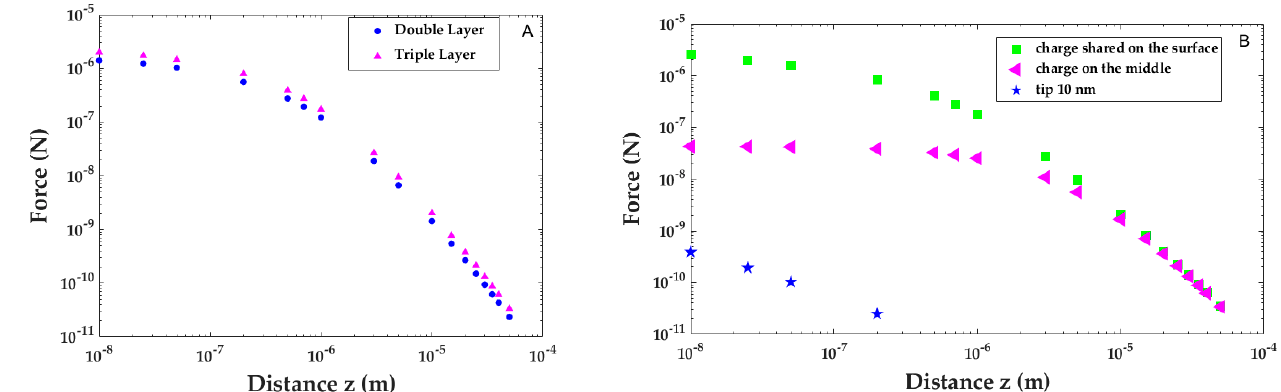
Figure 3. ( A ) Modeling of the interaction between a surface covered by dipoles and a charged sphere of 10 µ m diameter by considering the simplified double layer (blue sphere) or triple layer model (pink triangles); and ( B ) modeling of the impact of the charge’s discretization on sphere surface. Repulsive force obtained between a dipole surface and a 10 µ m charged sphere with the charge fairly shared on the surface (green squares), centered at the middle of the sphere as a point charge: the same charge as previous, but located in the sphere center (pink triangles) or 10 nm charged tip (blue stars).